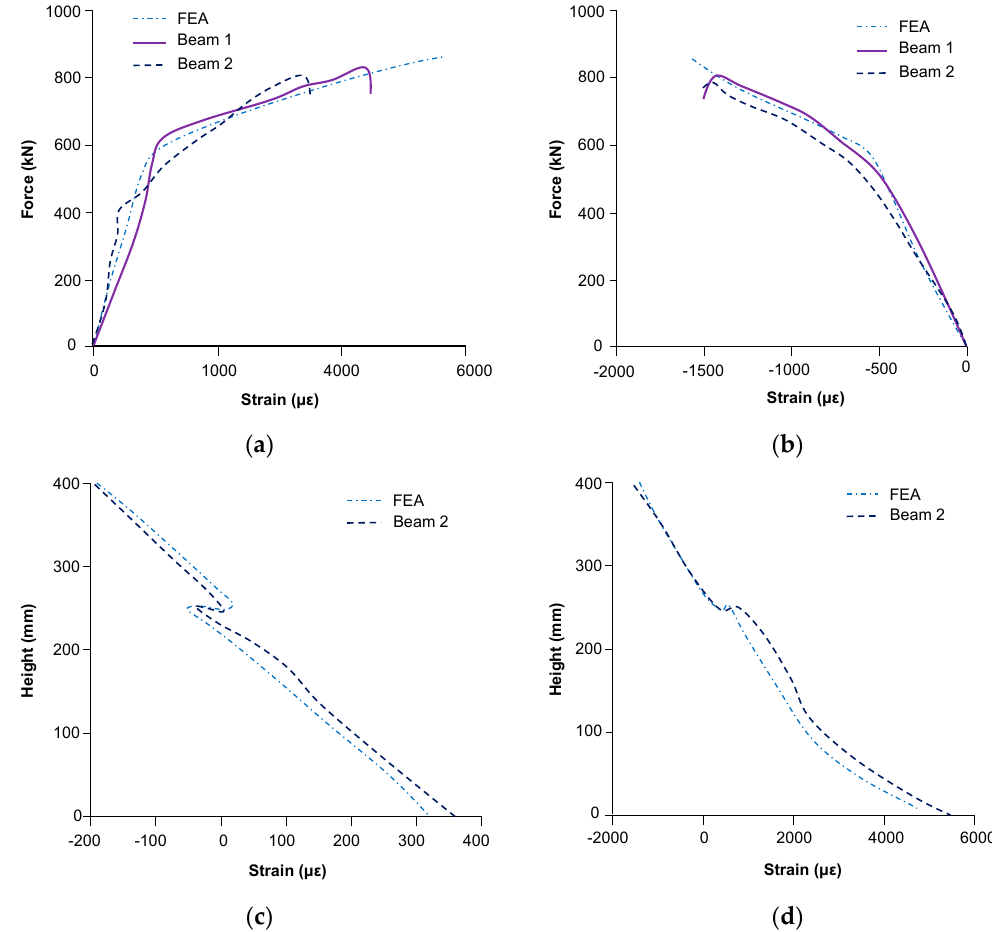
Figure 20. Comparison of strain: ( a ) strain at the bottom of the steel beam; ( b ) strain at the top of the concrete slab; ( c ) strain distribution on sections at the load of 200 kN; ( d ) strain distribution on sections at the load of 800 kN.